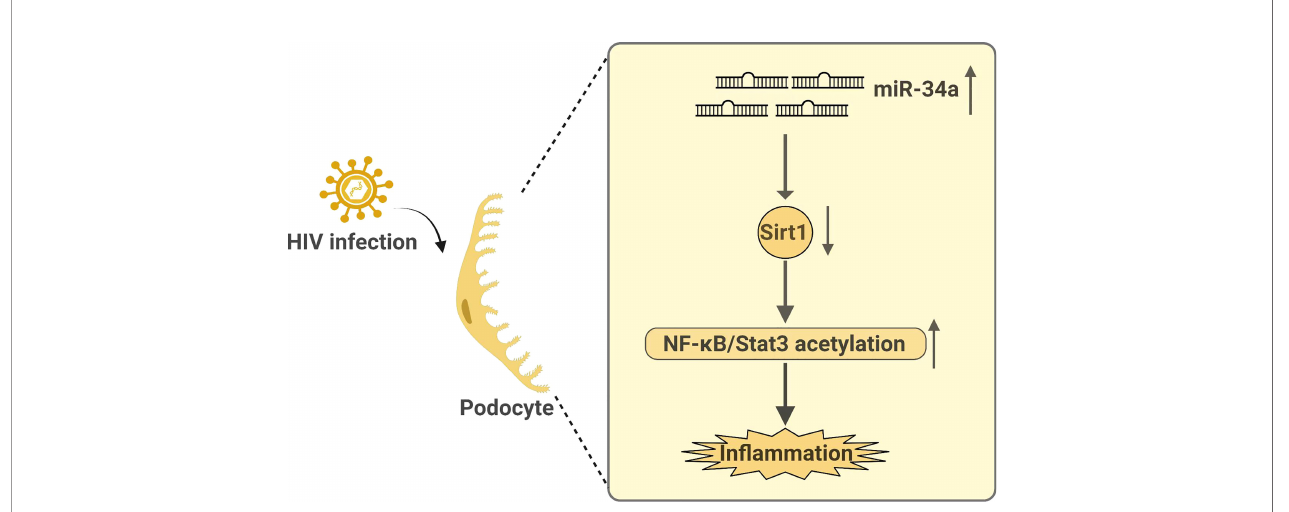
FIGURE 1 | Summary on how HIV infection regulates Sirt1 expression and how Sirt1 mediates HIV infection-induced kidney